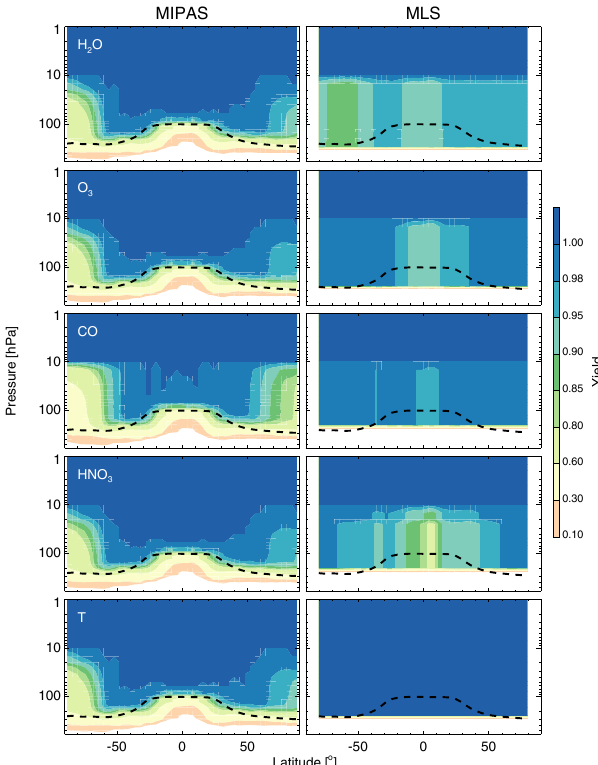
Figure 2. MIPAS and MLS zonal mean yield ( N QS /N A , where N A is the number of measurements available and N QS is the number of measurements left after applying the quality screening criteria) for H 2 O, O 3 , CO, HNO 3 , and temperature for 2005, that is, sampling the modelled 2005 year with the sampling patterns as explained in the text. Note the non-linear colour scale. The dashed black lines show the mean 2005 thermal tropopause derived from the Modern Era Retrospective Analysis for Research and Application-2 (MERRA2) fields (Bosilovich et al., 2015). This tropopause infor- mation was obtained from the derived meteorological products as described by Manney et al. (2007,